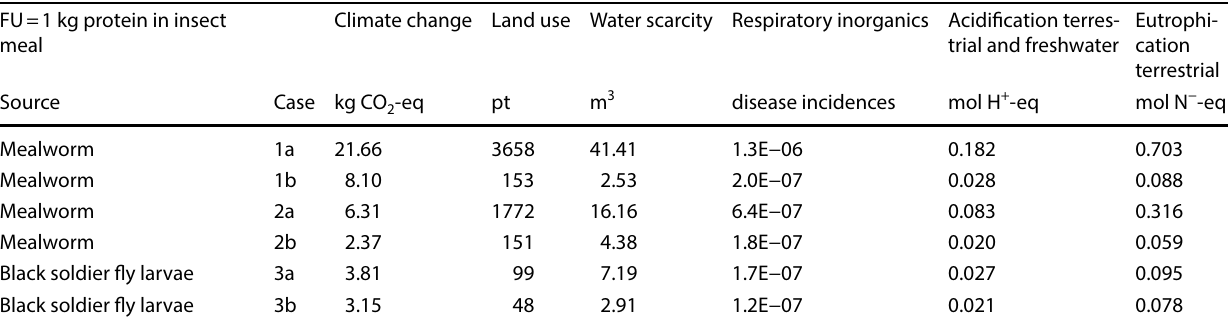
Table 4 Results for the environmental performance of rearing and processing insects into insect meal (per kg protein delivered to the west coast of Norway) FU = 1 kg protein in insect meal